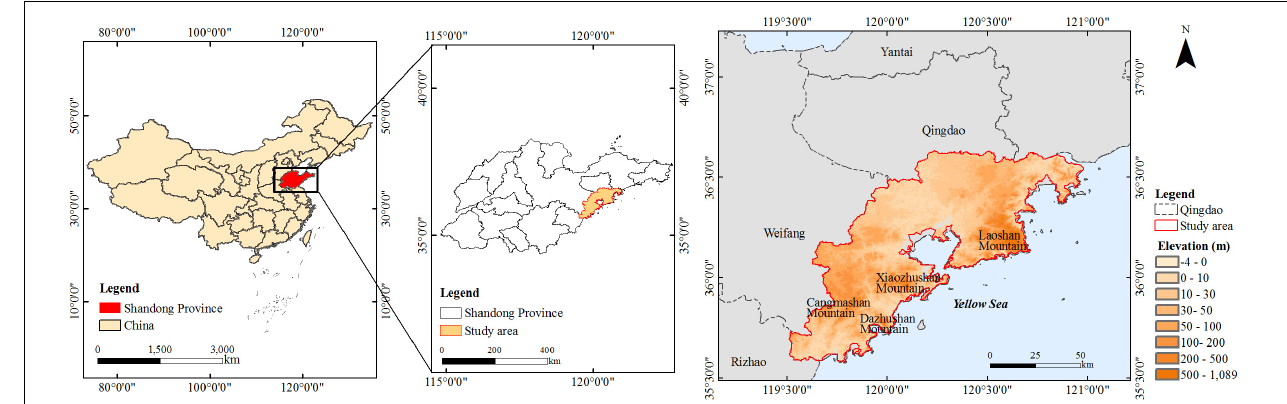
FIGURE 2 | Location and elevation data of study